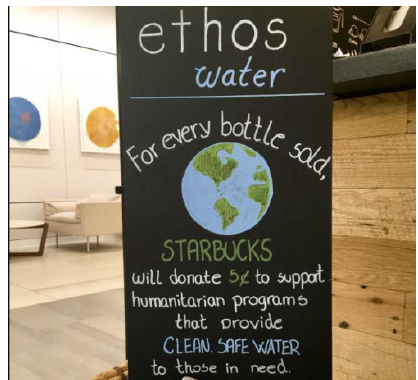
Figure 29. Starbucks Ethos Water Project [81].